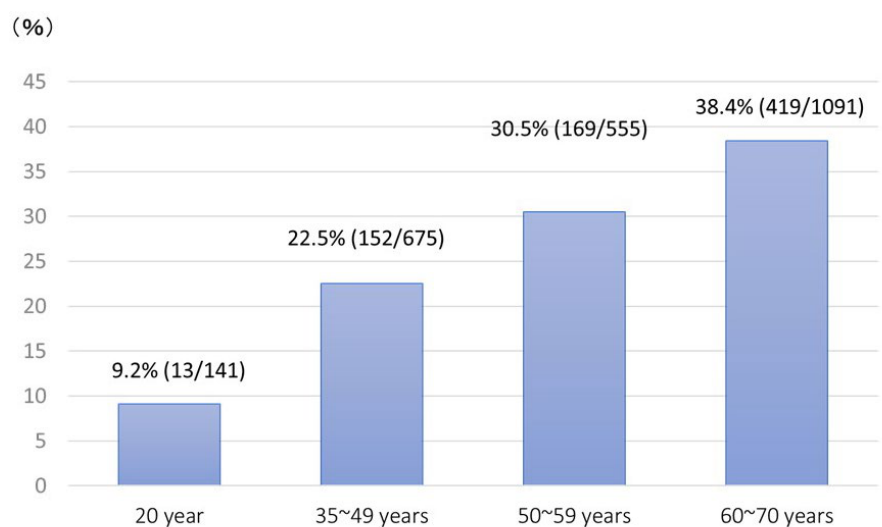
Figure 2. The frequency of H. pylori positivity according to age (2014~2018). Table 1. Results of H. pylori antibody test project in Hoki-cho, Tottori Prefecture.